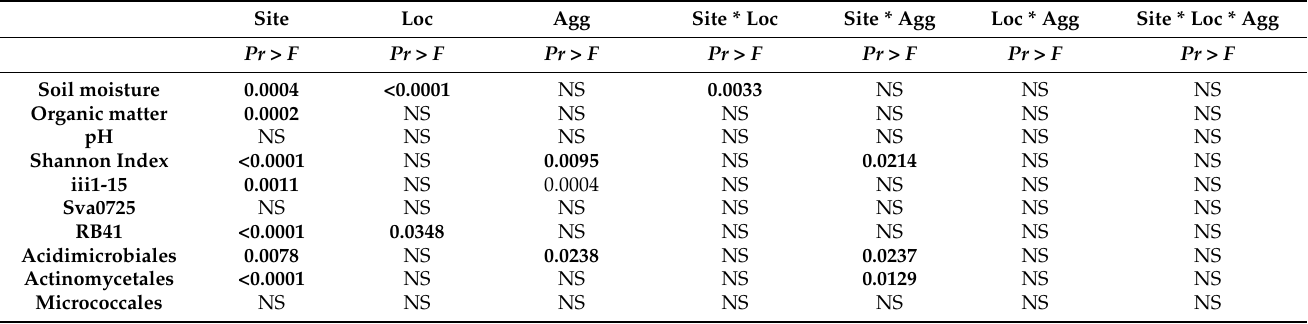
Figure 1. Changes in mean values of abiotic parameters: ( a ) soil moisture, ( b ) pH, and ( c ) soil organic matter at different agro-management: organic (Y) and conventional (Ba); at different sampling locations: between (B) the plant rows and in the vine rows (R); and with different aggregate sizes (0.5, 1, and 8 mm). The horizontal line in the box plot indicates the median, and the box indicates the upper and lower quartiles, with vertical lines representing the minimum and maximum values. Table 1. Univariate analysis of variance (ANOVA) for soil properties and soil bacterial orders from different sampling sites, locations, aggregate size, and the interactions between them. Site indicates treatment, location indicates sampling location (between or within rows), and agg indicates aggregate